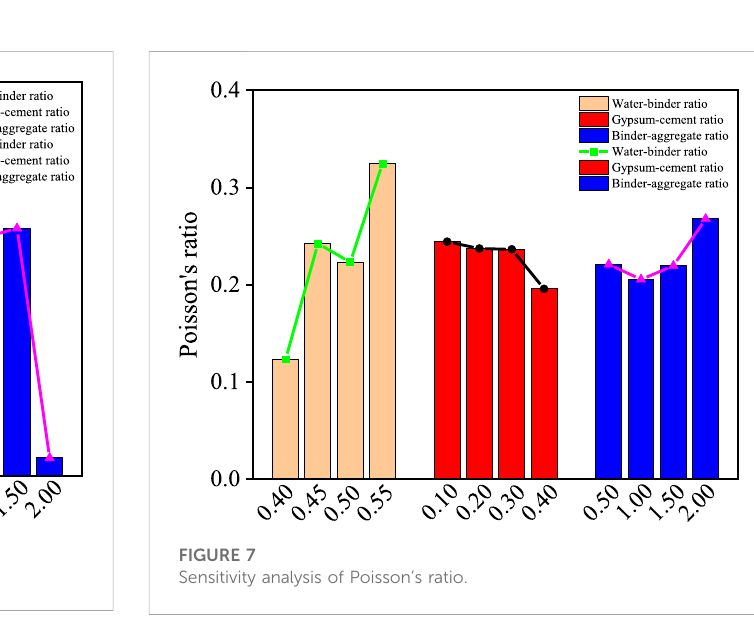
FIGURE 6 Elastic modulus sensitivity analysis.